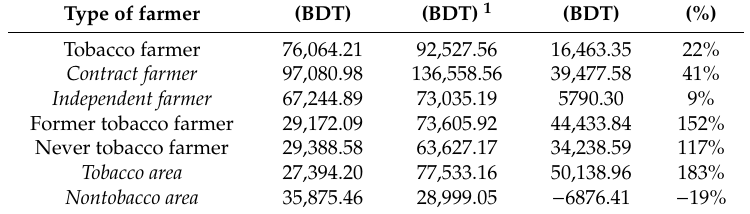
Table 9. Cost of production, sales revenue and profit per acre of land by type of farmers.